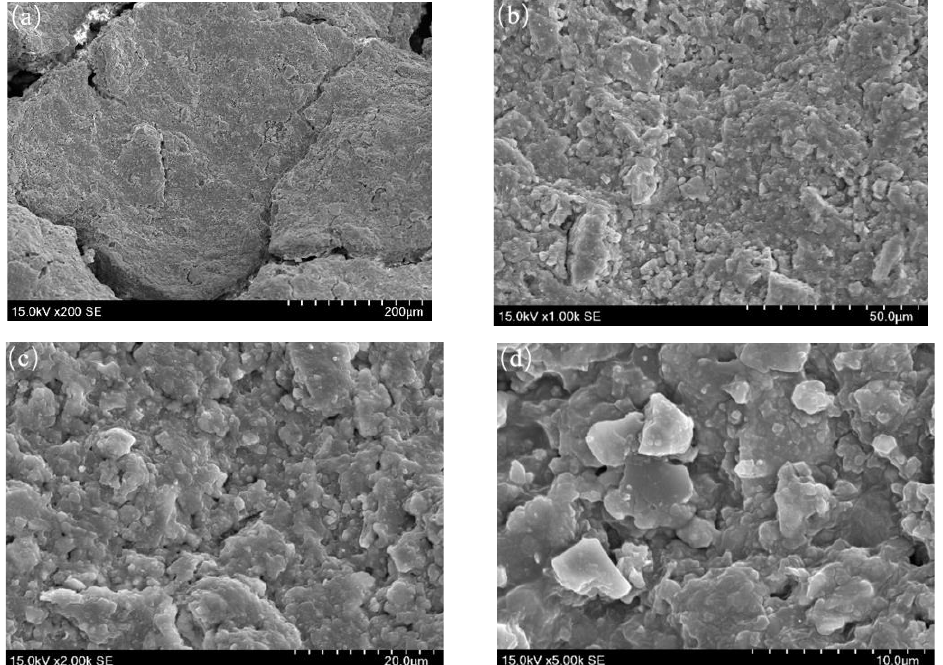
Figure 7. SEM images of surface morphology on inner wall of tubing. ( a ): 200 × SEM; ( b ): 1000 × SEM; ( c ): 2000 × SEM; ( d ): 5000 × SEM.